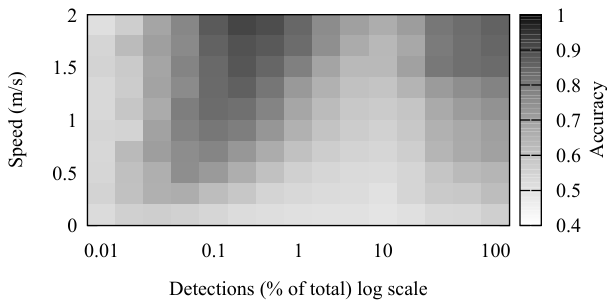
Figure 5. Effects of speed and detection frequency on the accuracy of